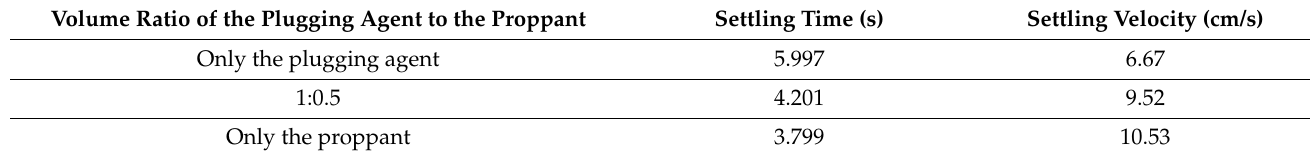
Table 6. Sedimentation rate (cm/s) of the plugging agent and proppant (density = 2.00 g/cm 3 ) in